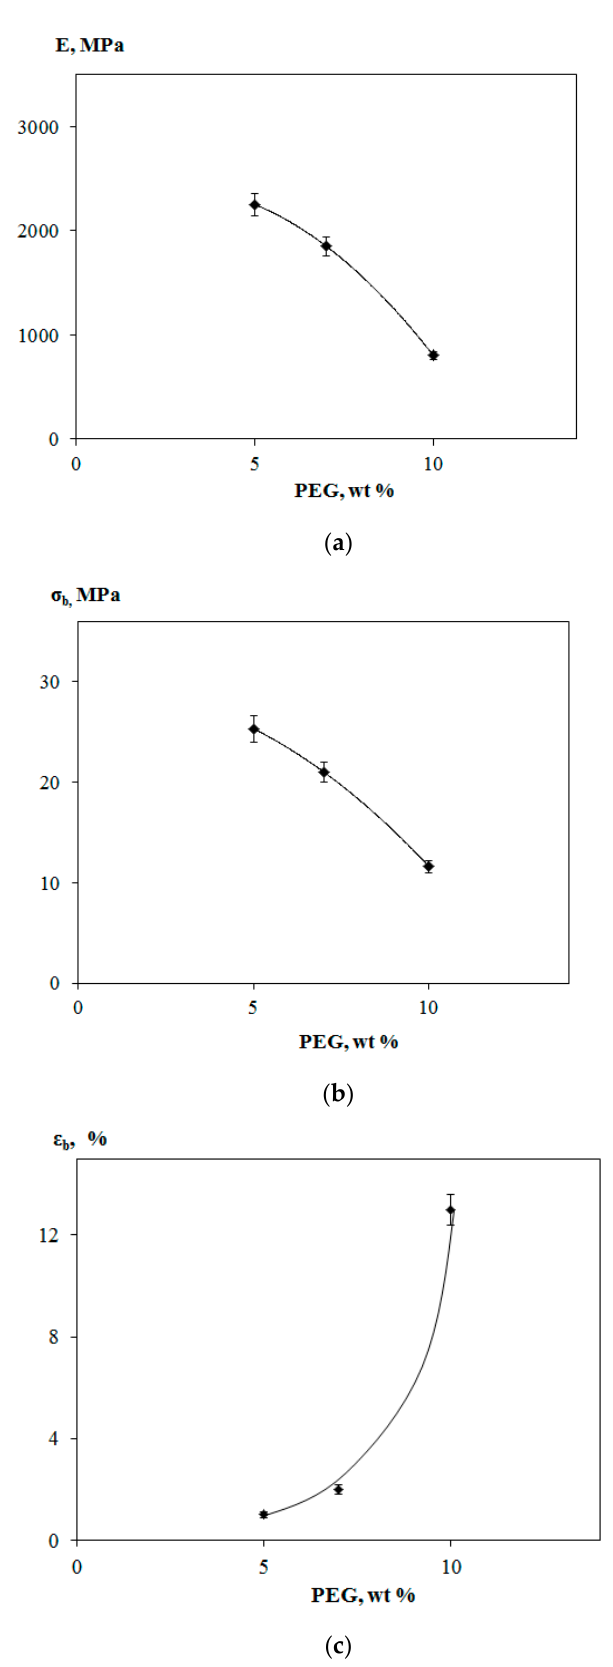
Figure 4. Elastic modulus E ( a ), tensile strength σ b ( b ), and elongation at break ε b ( c ) of Figure4. Elasticmodulus E ( a ), tensilestrength σ b ( b ), andelongationatbreak ε b ( c )ofPLA–PHB–PEG 400 PLA − PHB − PEG 400 compositions vs. PEG content. compositions vs. PEG